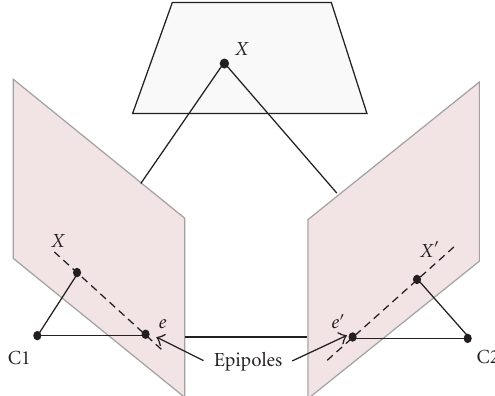
Figure 2: Epipoles of a pair of cameras—the points where the line that connects the centers of the cameras intersects the cameras’ image planes [10,